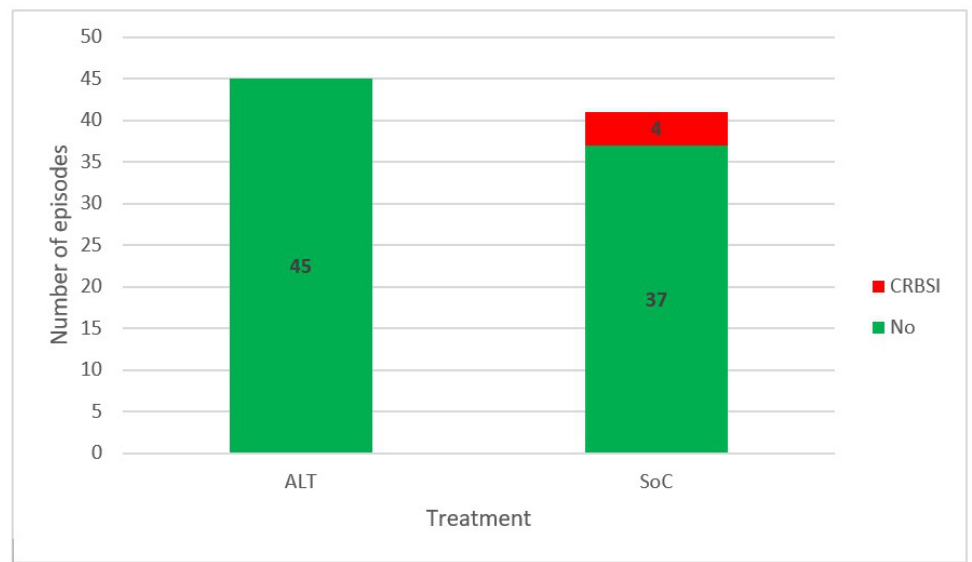
Figure 2. Progression to catheter-related bloodstream infection in the following 30 days of diagnosis. Abbreviations: ALT, antimicrobial lock therapy; SoC, standard of care; CRBSI, catheter-related bloodstream infection.